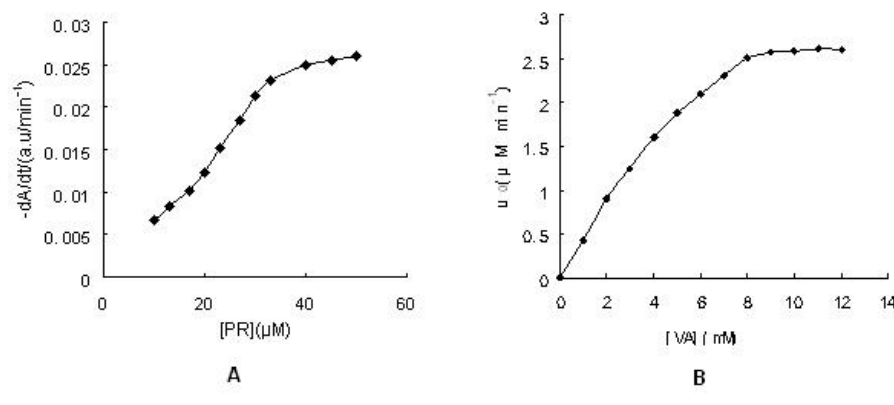
Fig. 1 Effect of the concentration of substrate on the LiP catalyzed oxidation of substrate (A, PR; B, VA). Conditions: [LiP] = 0.1 μ M; [H 2 O 2 ] = 20 μ M (A), 60 μ M